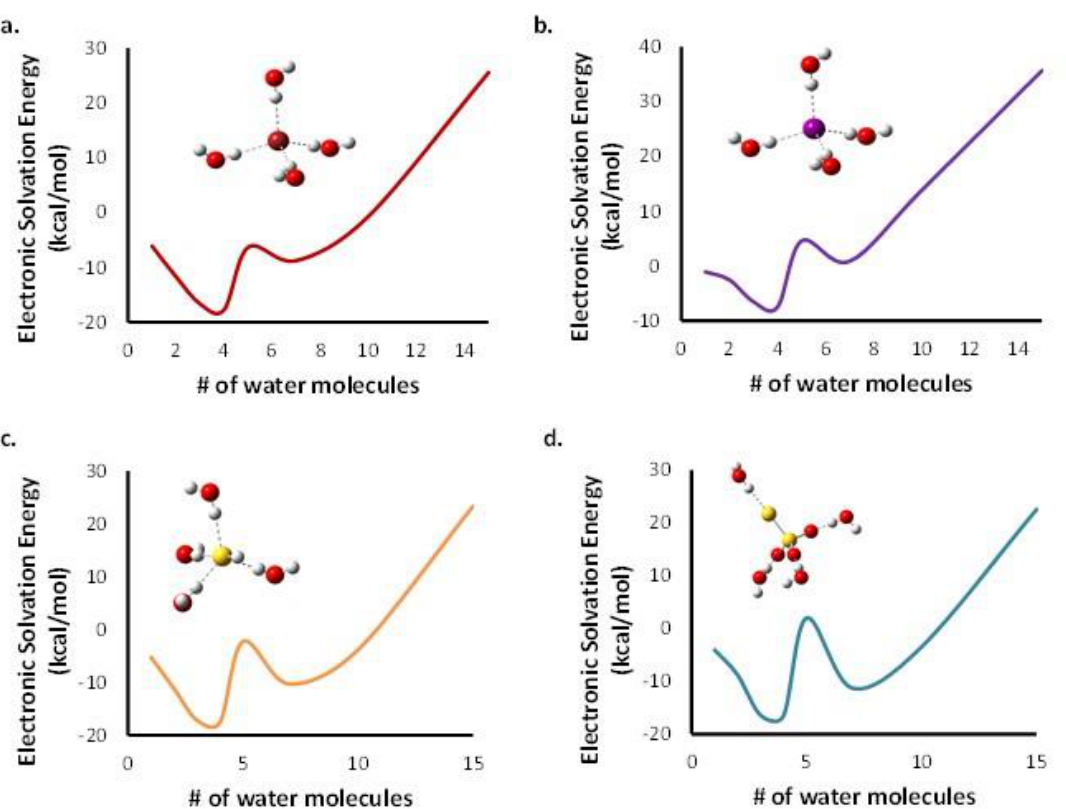
Figure 1. Solvation electronic energy of bromide ( a ), iodide ( b ), bisulfide ( c ), and thiosulfate ( d ) ions using a different number of water molecules. Table 1. Activation free energy in kcal/mol of the S N 2 reaction of chloroacetanilides in